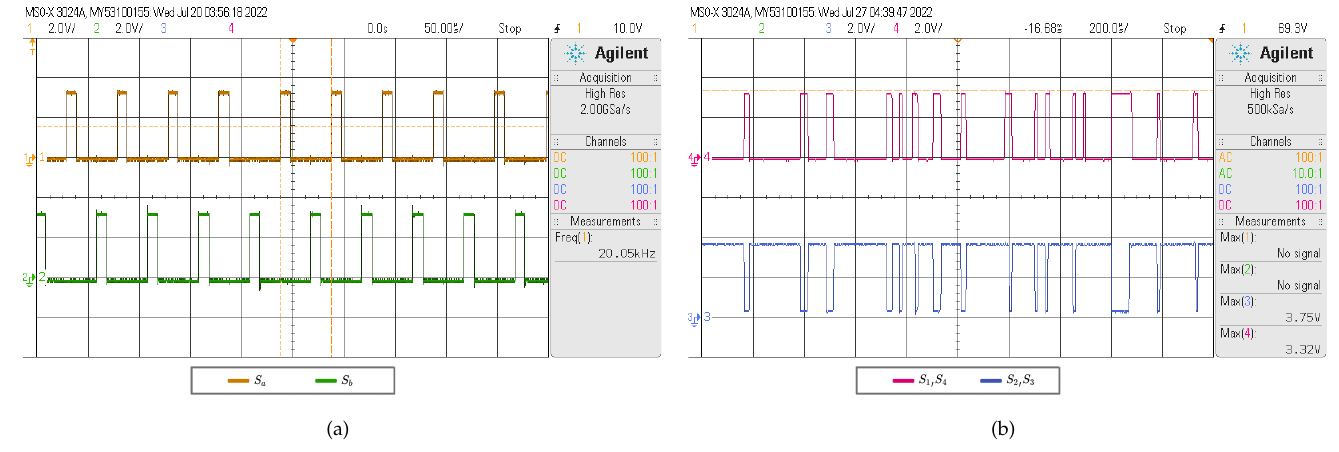
Figure 5. ( a ) Commutations in the semiconductors on the push–pull converter, ( b ) commutations in the semiconductors on the H bridge inverter.